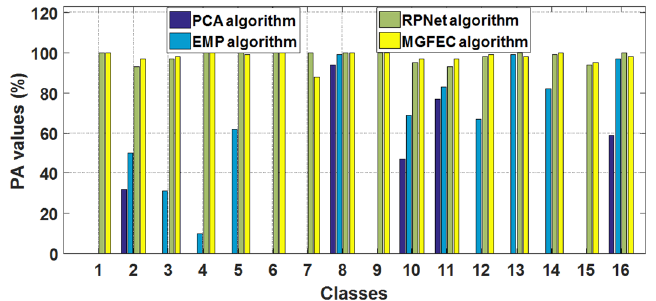
Figure 9. Comparison of PA values of different algorithms on the dataset shown in Fig.